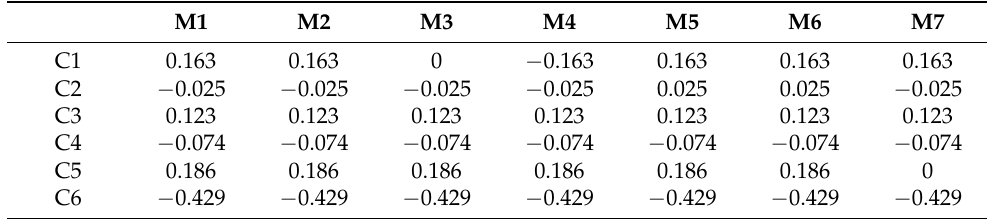
Table 12. Second step of PUGH weighing matrix.